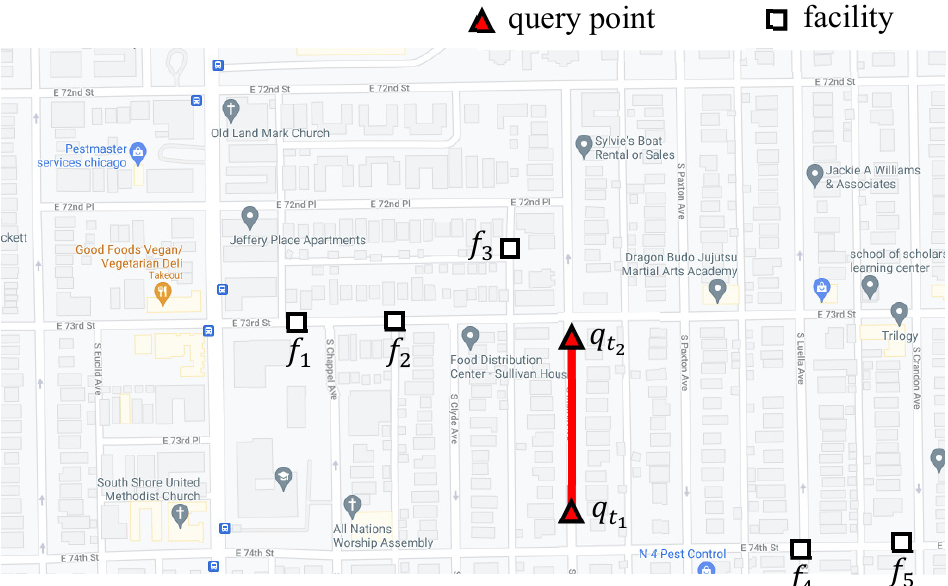
Figure 1. Example of M k FN queries in a road network.